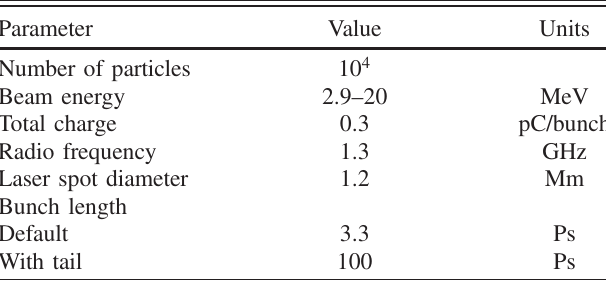
¼ 100 ps longi- cutoff